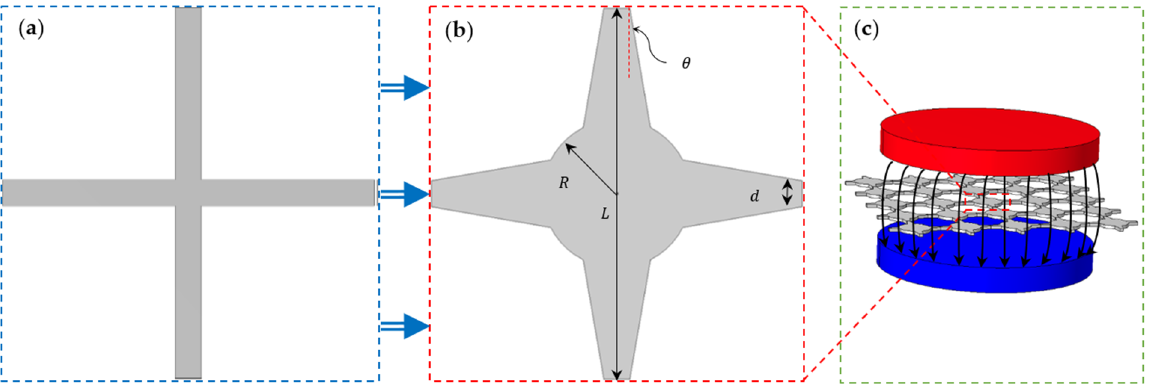
Figure 1. Schematic of in-plane periodic architected metamaterial: ( a ) the conventional square unit cell; ( b ) the square unit cell with cylindrical core and trapezoidal arm; ( c ) periodic structure affected by magnetic fields.